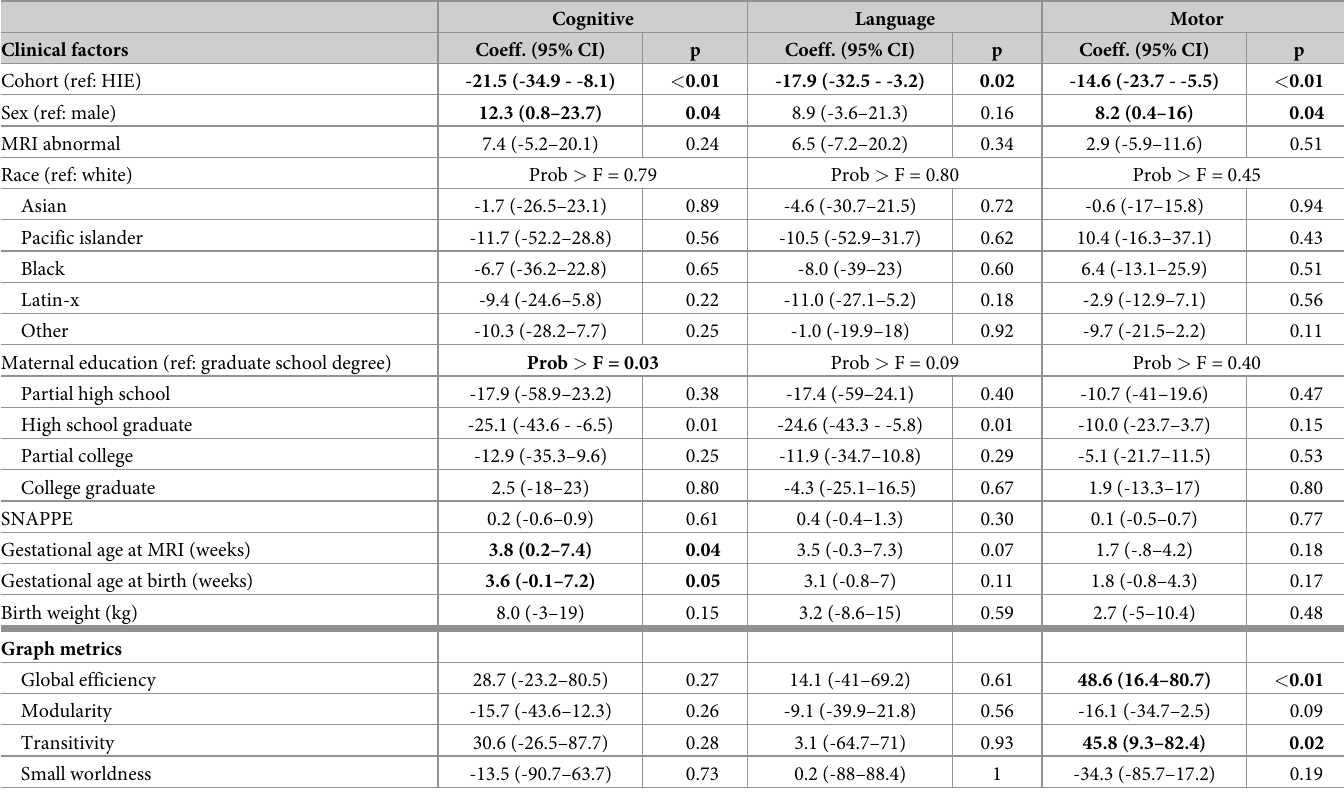
Table 4. Univariate analysis of 30 month neurodevelopmental outcomes.